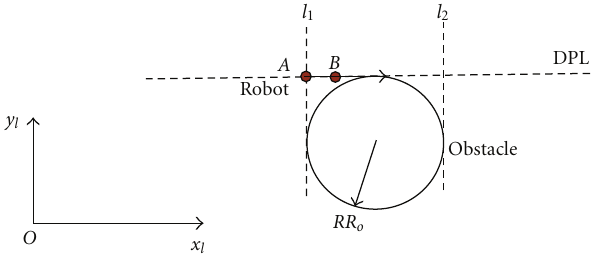
Figure 19: Limitation of the obstacle-avoidance